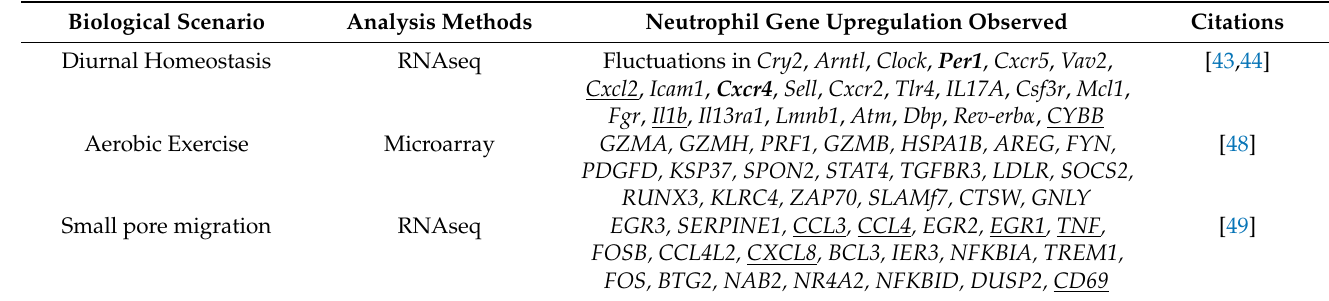
Table 1. Summary of upregulated gene expression during neutrophil homeostasis and major functions. Genes featured are restricted to those highlighted by the original authors and/or the largest fold change reported by the study. Bold indicates common to the studies cited, underlined indicates common to multiple biological scenarios. RNAseq—RNA sequencing; NETosis—neutrophil extracellular trap